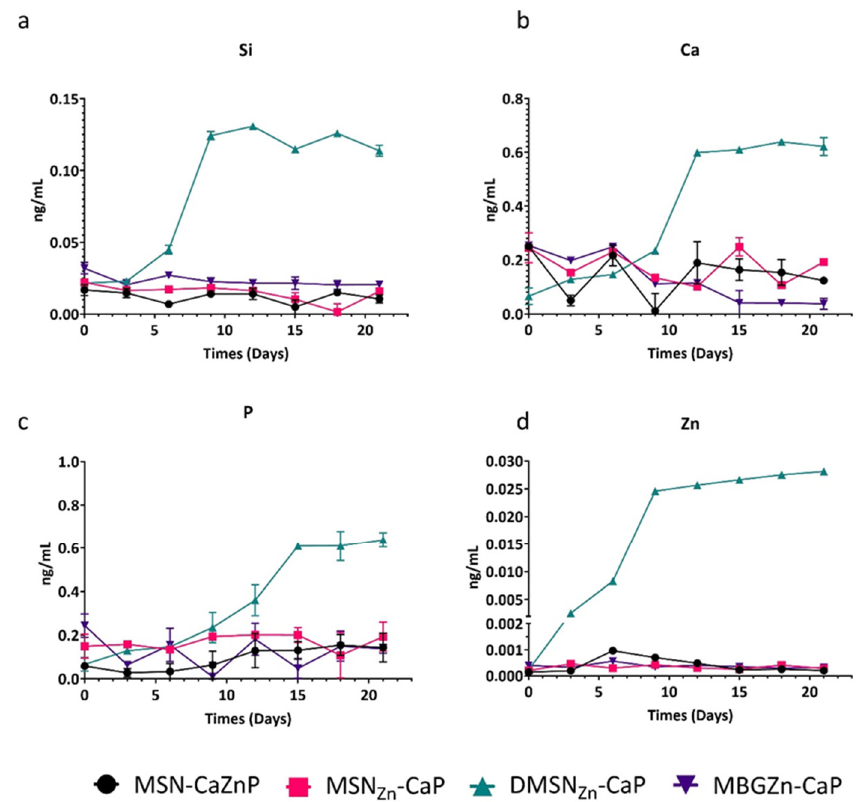
Figure 3. Ion release profiles analyzed using ICP-MS of ( a ) Si, ( b ) Ca, ( c ) P and ( d ) Zn from MSN- CaZnP (black), MSN Zn -CaP (red), DMSN Zn -CaP (green) and MBGZn-CaP (purple) in cell culture media at 37 °C, 5% CO 2 in a humidified atmosphere.